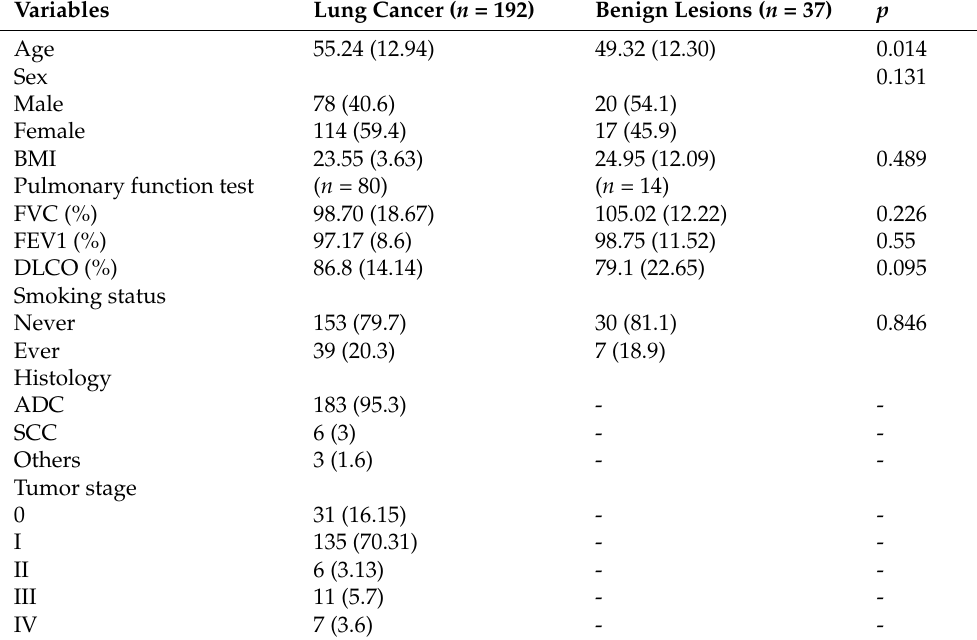
Table 1. Baseline clinical characteristics of the study